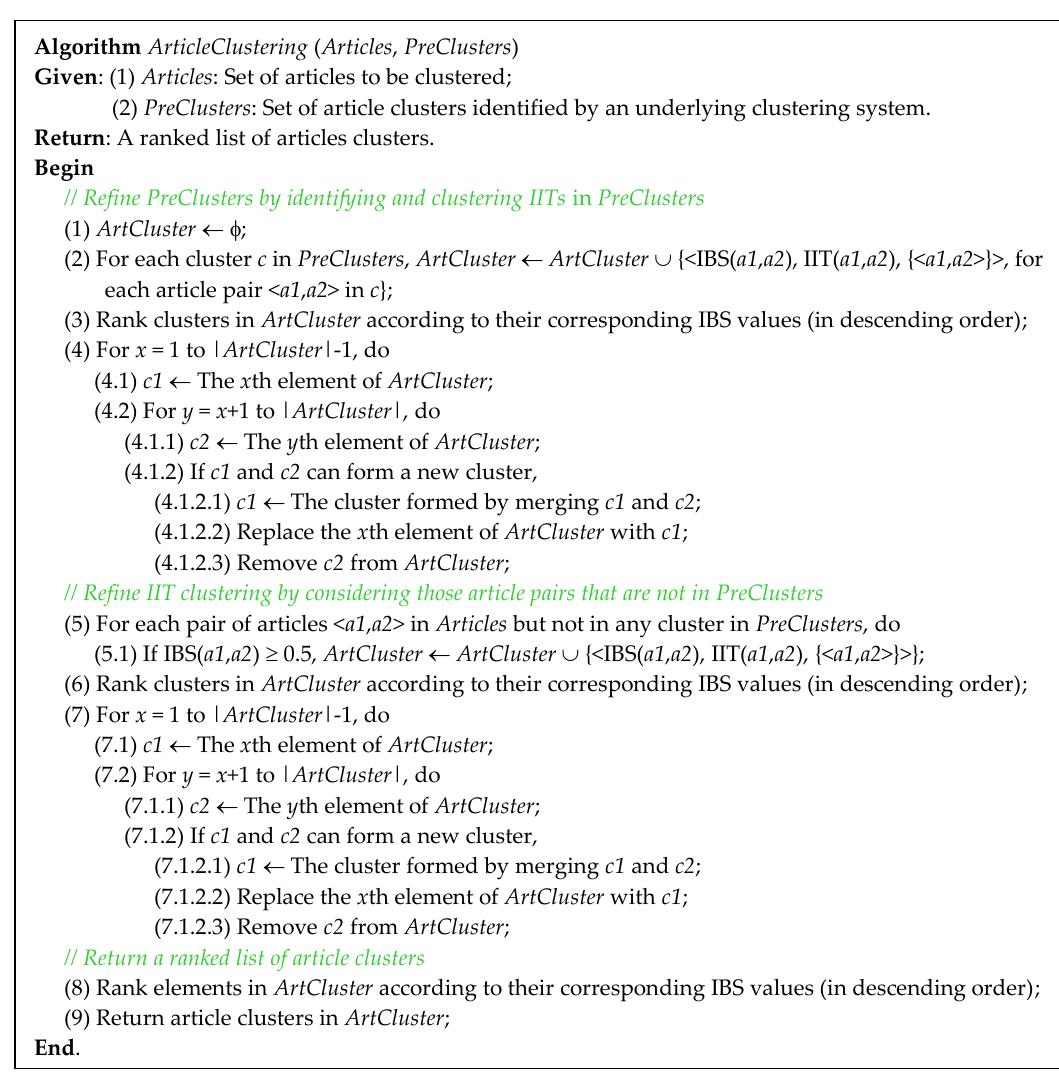
Figure 3. The algorithm to cluster articles by clustering IITs